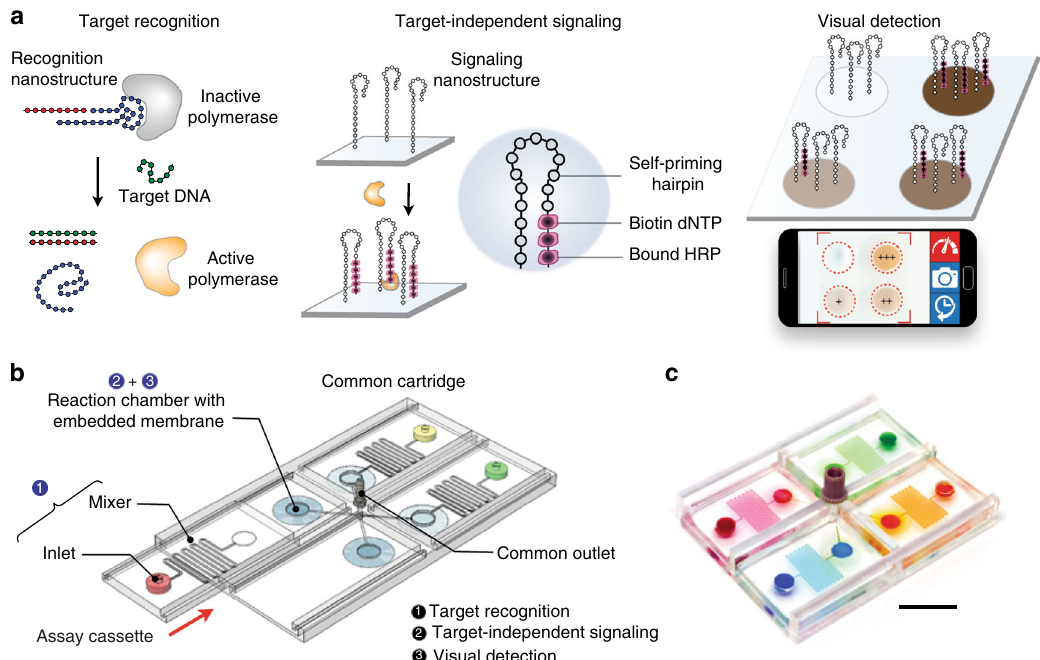
Fig. 1 Visual and modular detection of pathogen nucleic acids. a The enVision system consists of a series of enzyme – DNA nanostructures to enable target recognition, target-independent signaling, and visual detection. The nanostructures are designed to decouple recognition from signaling. The recognition nanostructure is a hybrid complex, composed of an inactivating aptamer and a Taq DNA polymerase. In the presence of complementary target DNA, the complex dissociates to activate the polymerase activity. The active polymerase proceeds to elongate a universal, self-priming signaling nanostructure, in a target-independent manner. Modi fi ed deoxynucleotides (dNTPs) are incorporated to immobilize horseradish peroxidase (HRP) onto the signaling nanostructures. Upon the addition of optical substrate, visual signals can be enzymatically enhanced, detected by the naked eye and quanti fi ed with a smartphone camera. Photograph (inset) shows an example of the actual visual readouts in the presence of none ( − ) and varying ( + ) amounts of target DNA on a smartphone application. b Schematic of the enVision micro fl uidic system. The platform is designed to complement the modular enVision work fl ow. Independent assay cassettes, preloaded with speci fi c recognition nanostructures at the inlets, can be mounted on-demand onto a common signaling cartridge. The common cartridge houses the universal signaling nanostructures, which are immobilized on embedded membranes, for target- independent signaling and visual detection. Direction of cassette sliding is indicated by a red arrow. c Photograph of the micro fl uidic enVision prototype, developed for versatile assay integration and parallel processing. Scale bar indicates 1